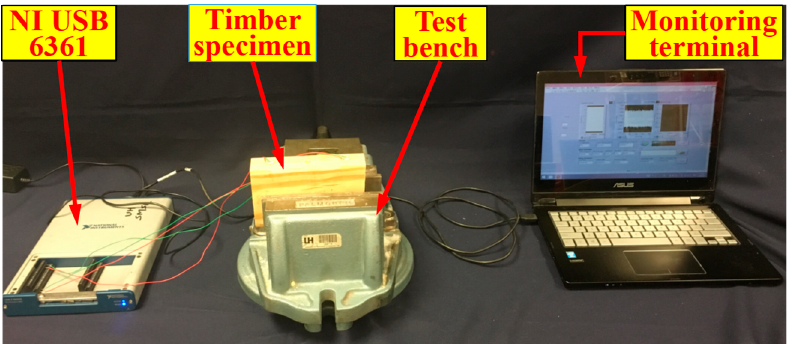
Figure 3. Experimental setup.